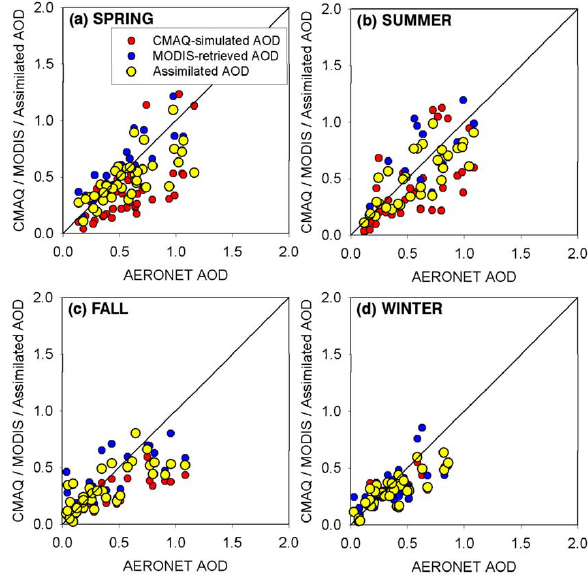
Fig. 10. Scatter plots of the CMAQ-simulated, MODIS-retrieved, assimilated and AERONET AODs for all four seasons, 2006. Red, blue and yellow circles indicate CMAQ-simulated, MODIS- retrieved and assimilated AODs, respectively: (a) spring, (b) sum- mer, (c) fall and (d)